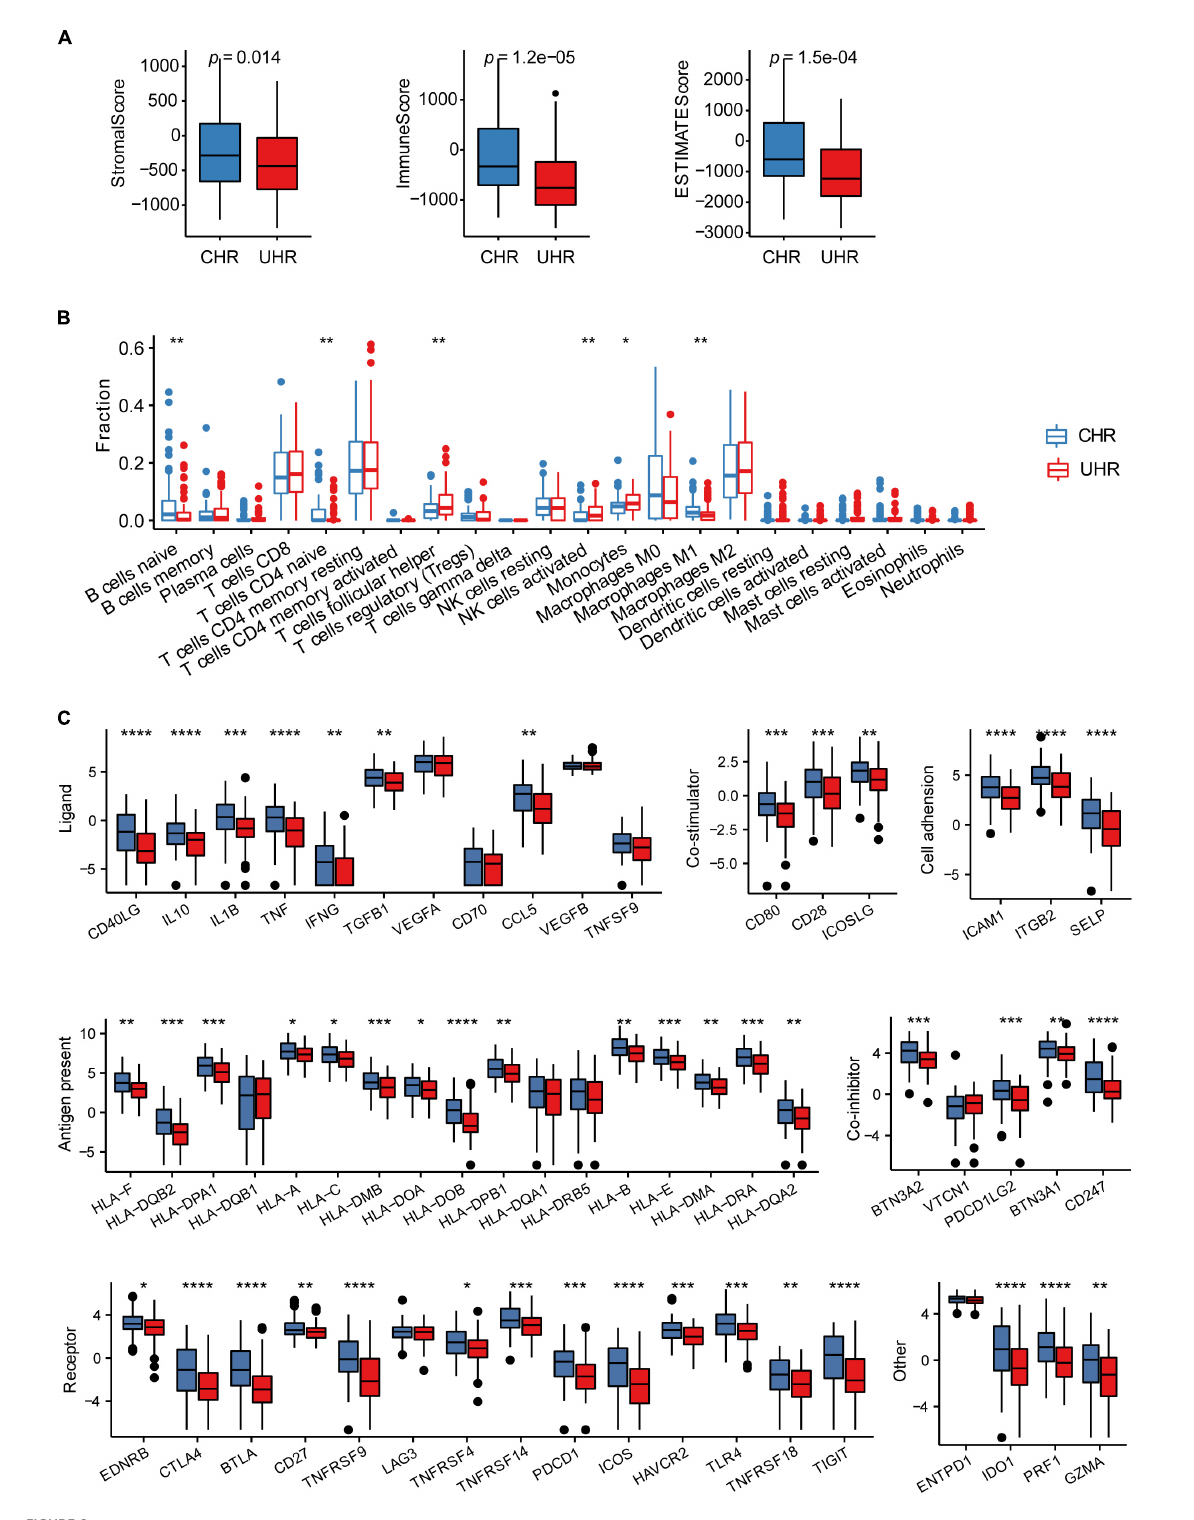
FIGURE6 The association between MMGS and the immune cell infiltration in the SEQC cohort. (A) Differences among stromal score, immune score, and ESTIMATE score between UHR and CHR groups. (B) The comparison of infiltration levels of 22 immune cell types between UHR and CHR groups. (C) Immune checkpoints expression between UHR and CHR groups. * p < 0.05; ** p < 0.01; *** p < 0.001; **** p < 0.0001; ns, no